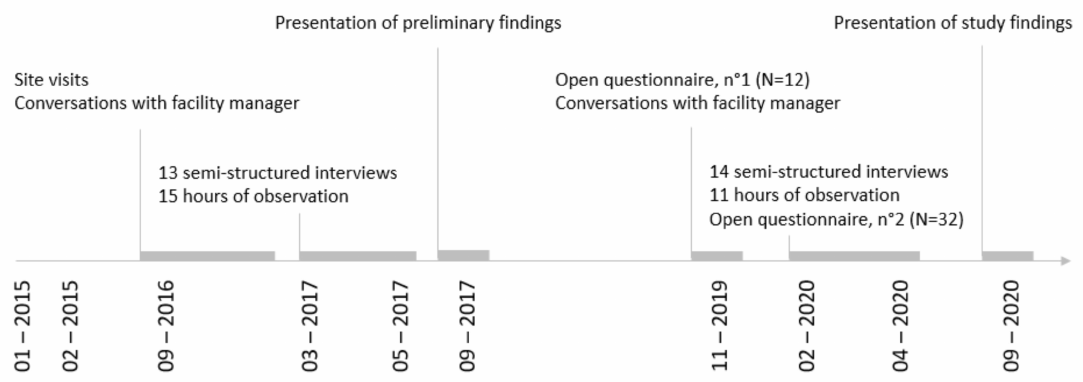
Figure 1. Data collection